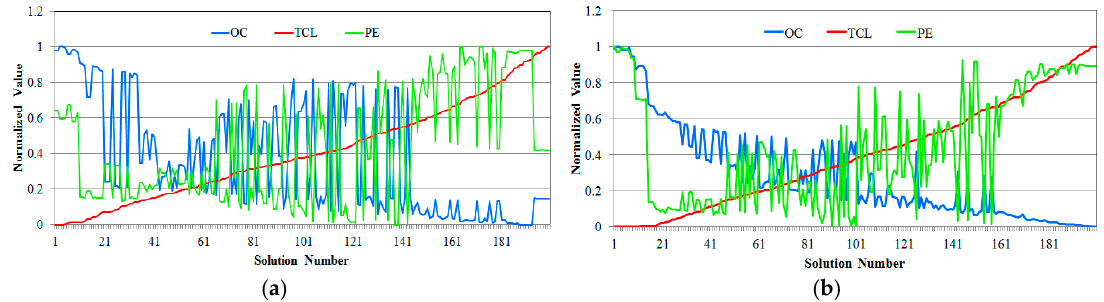
Figure 12. The normalized objectives of Pareto front of optimal scheduling for the RR-microgrid with CHCS. ( a ) A typical day in winter; and ( b ) a typical day in summer.